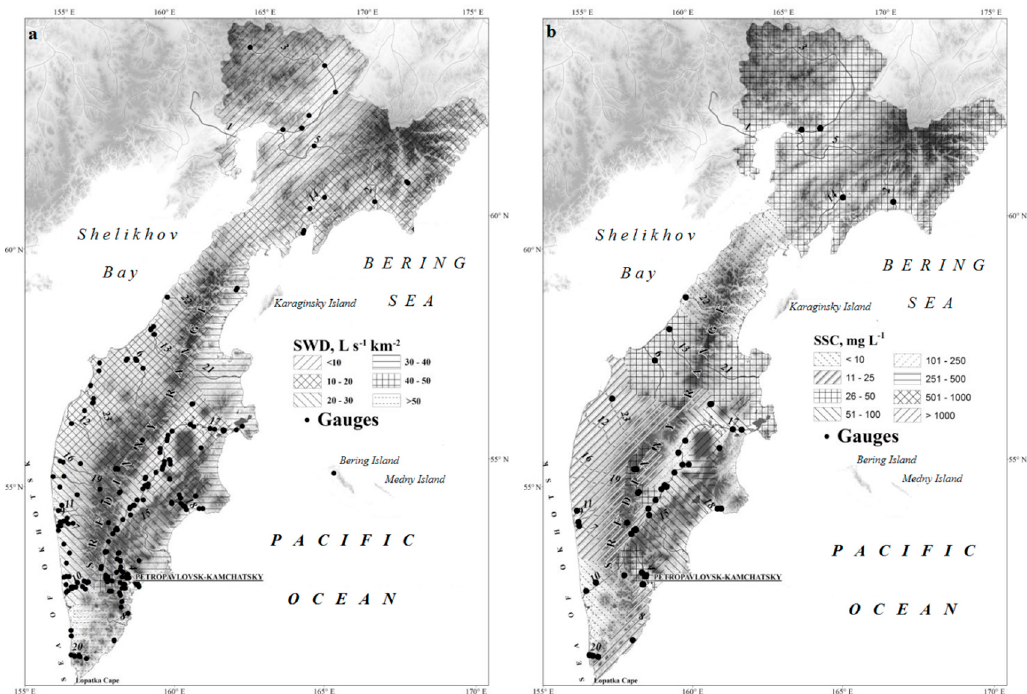
Figure 2. Distribution of monitoring stations measuring water discharge and specific water discharge ( a ) and suspended sediment yield and suspended sediment concentration ( b ) in the Kamchatsky Krai.